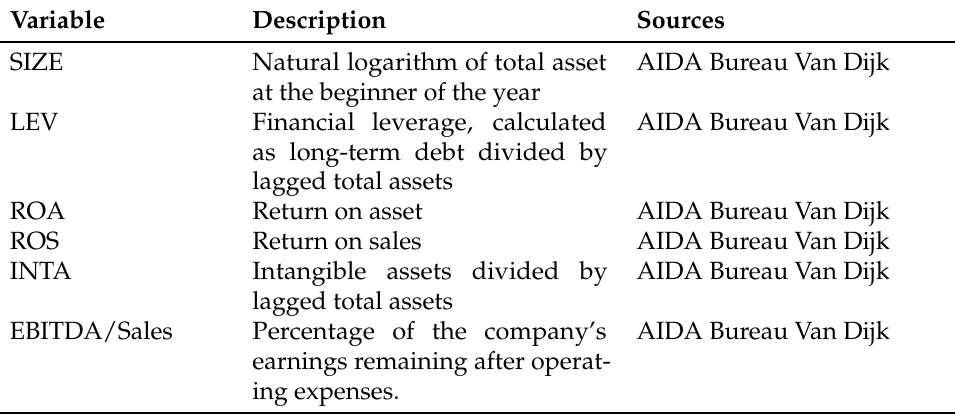
Table 1. Variables